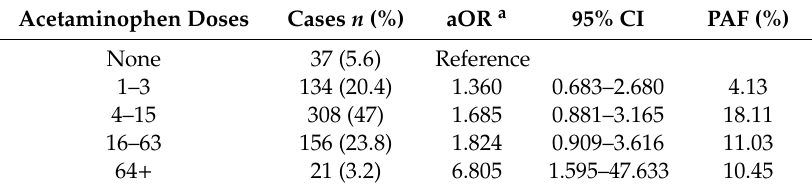
Table 6. PAF associated with postnatal acetaminophen among males by